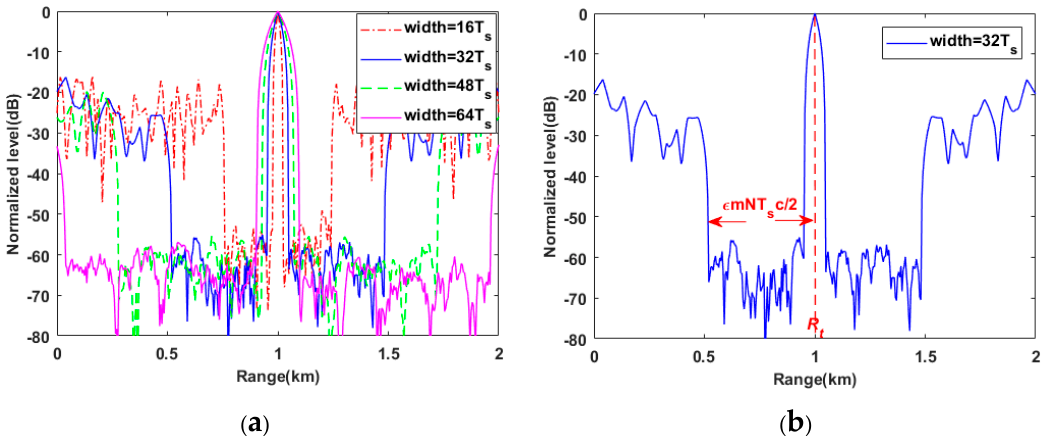
Figure 3. ( a ) The matched filter results versus ranges for the PeWISL sequences with coding width 16 T s ,32 T s ,48 T s ,64 T s ; ( b ) the optimized range interval corresponding with range interval (32) when the coding width is 32 T s